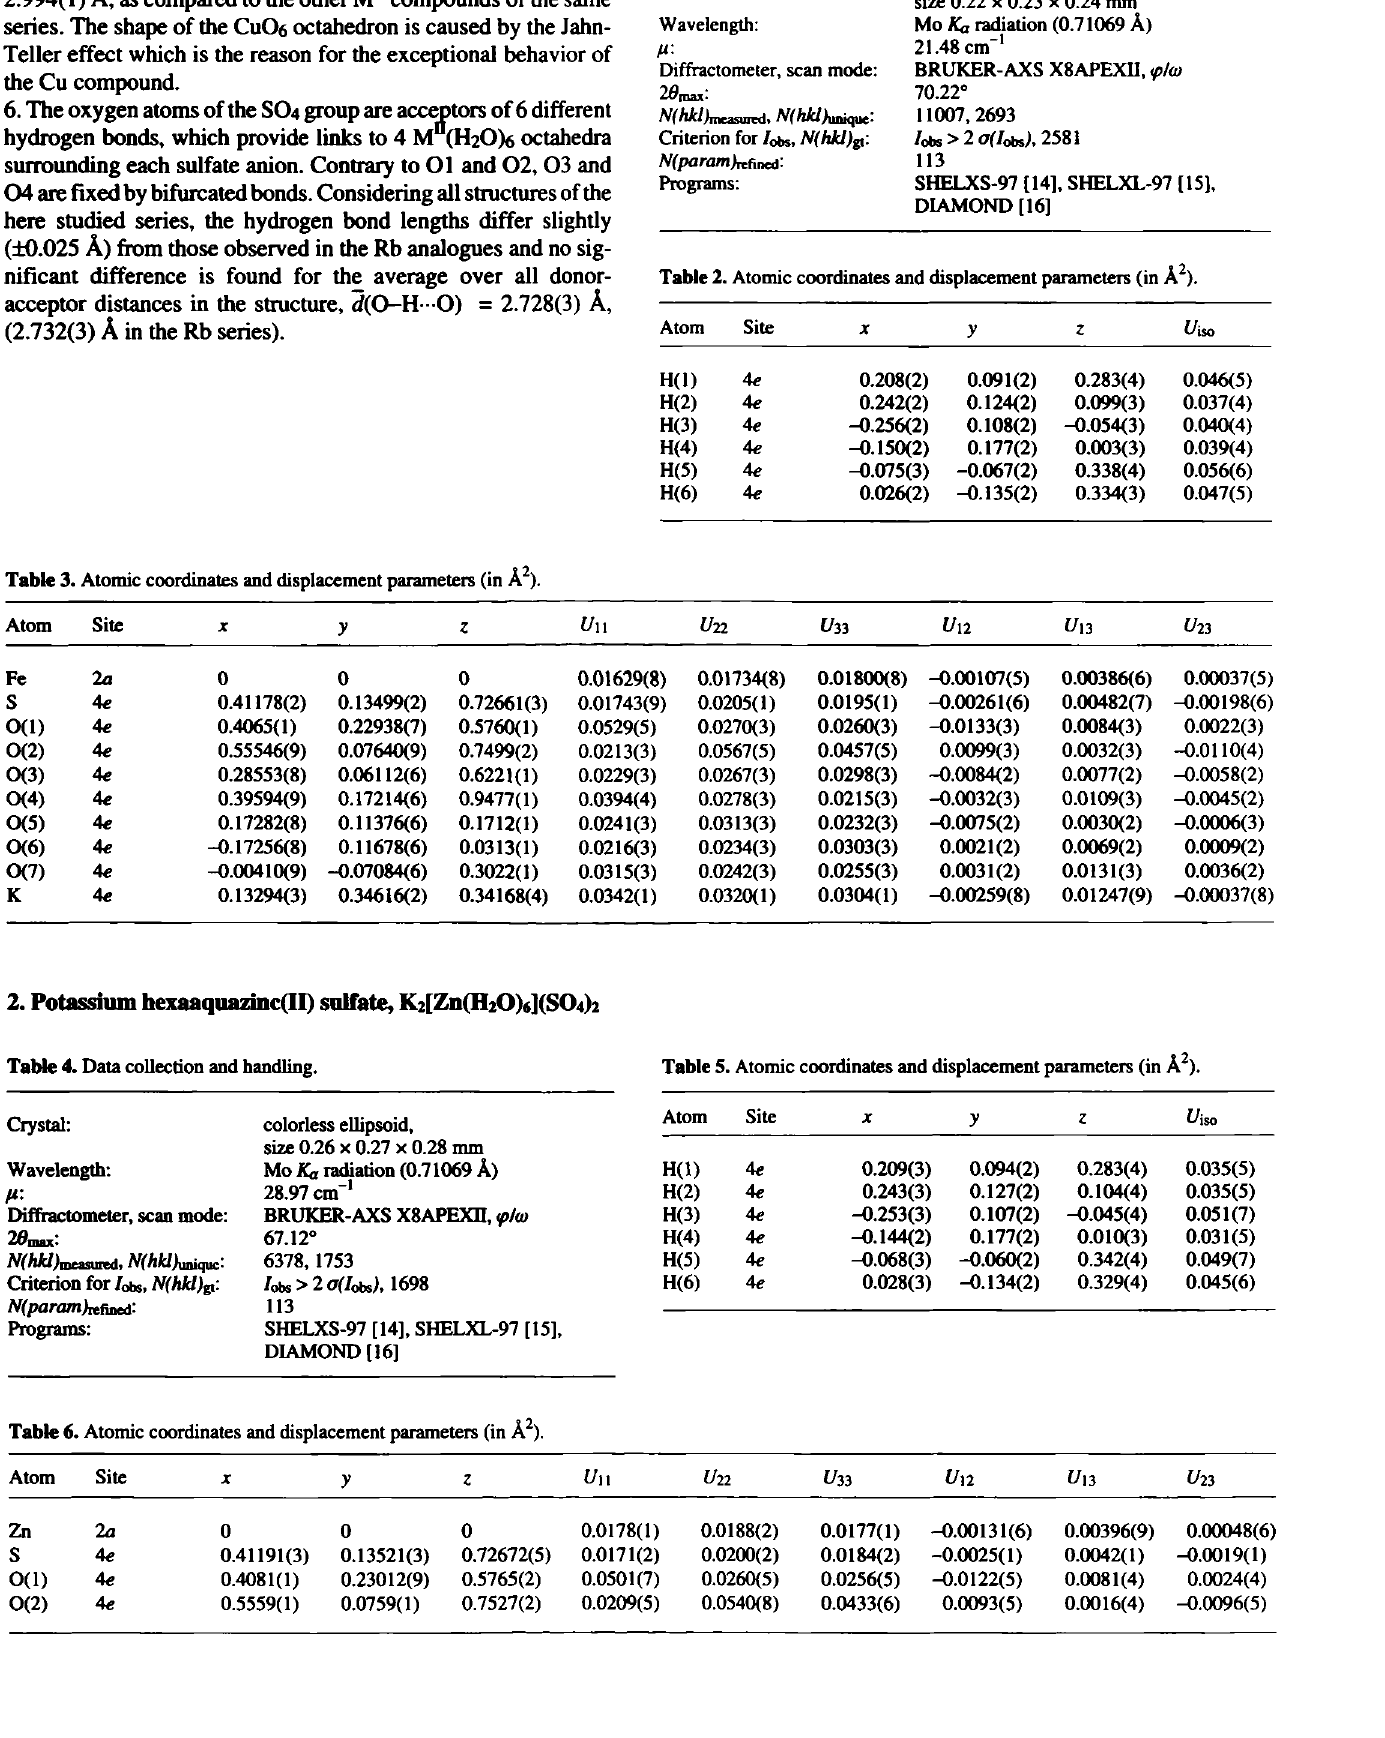
Table 6. Atomic coordinates and displacement parameters (in Â 2